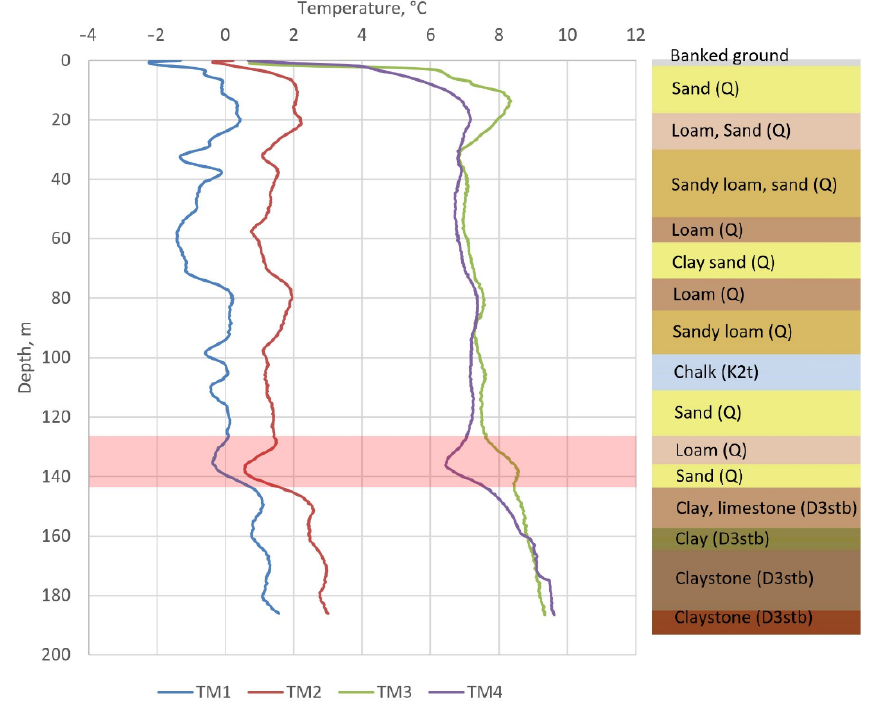
Figure 2. Experimentally measured temperature distributions along the depth of TM wells (measurement date: 3 February 2021).